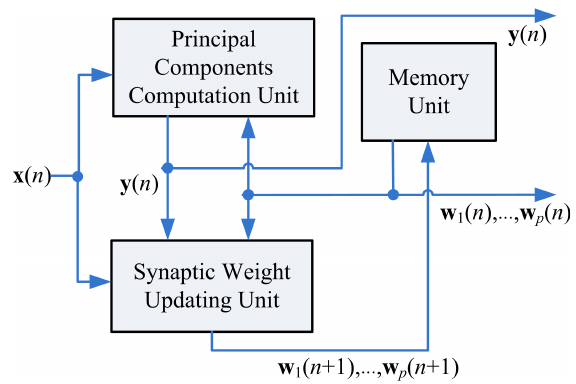
Figure 2. The proposed GHA